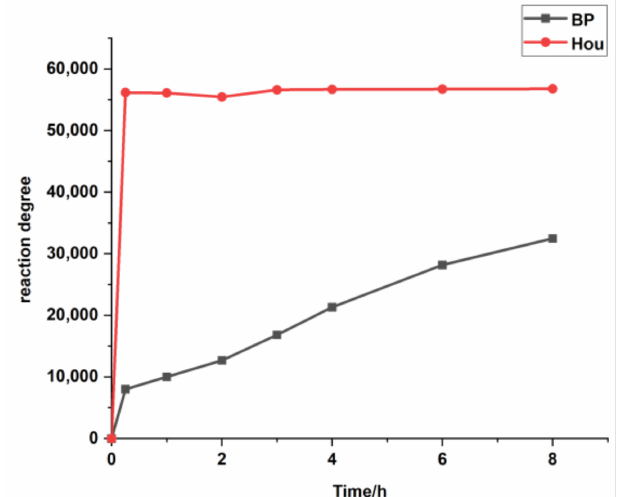
Figure 1. The response values of the derivatives in the LC-MS/MS with increasing reaction time. BP: benzophenone: Hou: